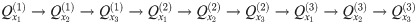
The sequence Q in two-dimensions.The stochastic trajectory X(t) (blue line), initiated from x0, intersects each of the transversal sections x1, x2 and x3 (dashed lines) of the limit cycle (red solid line) three times, following a path Qx1(1)→Qx2(1)→Qx3(1)→Qx1(2)→Qx2(2)→Qx3(2)→Qx1(3)→Qx2(3)→Qx3(3).